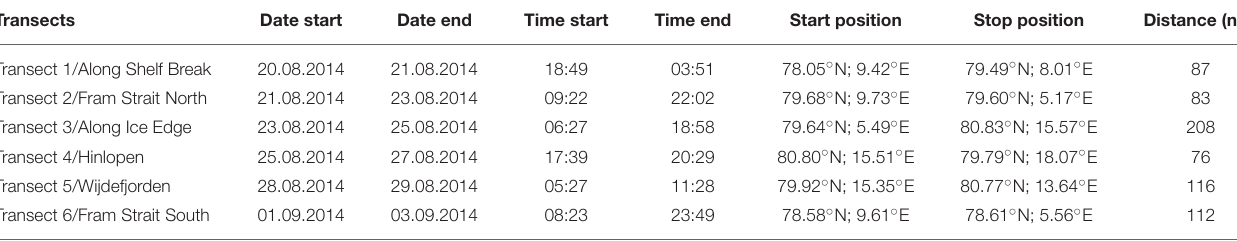
TABLE 1 | Logistics information for acoustic Transects 1–6. Transects